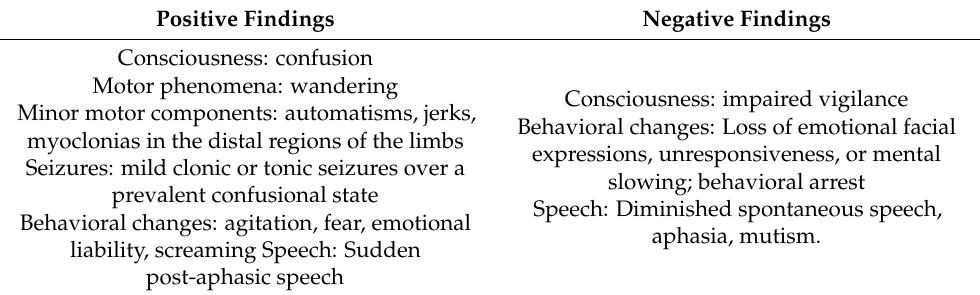
Table 5. Clinical features of Non-Convulsive Status Epilepticus in patients with Ring